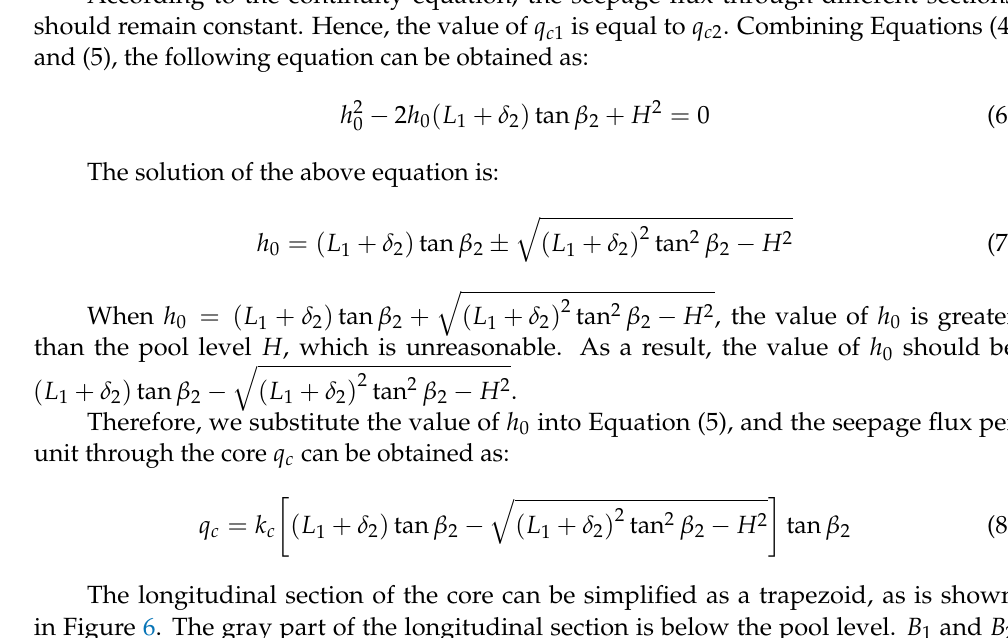
Figure 6. The gray part of the longitudinal section is below the pool level. resent the length, m, of the top and bottom of the gray part, respectively. represent the included angle between the left and right sides of the core and the horizontal plane, respectively. The core can be divided into three parts for convenience of calculation.